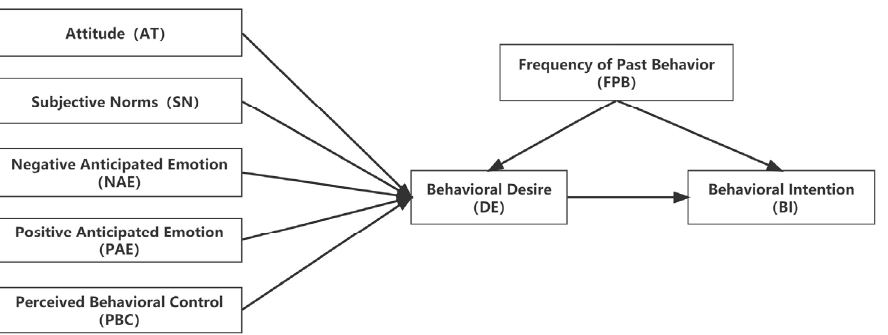
Figure 1. Goal-oriented behavioral theory model.